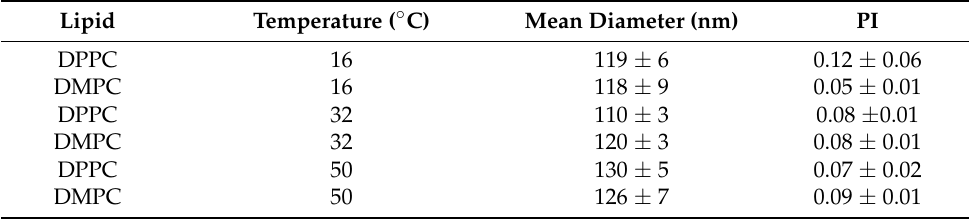
Table 1. Hydrodynamic mean diameters and polydispersity indexes (PI) obtained by DLS for the DPPC and DMPC vesicle dispersions used in this work. The number of performed measurements per sample is n = 4. The calculated errors are the standard deviation of the average values based on several independent